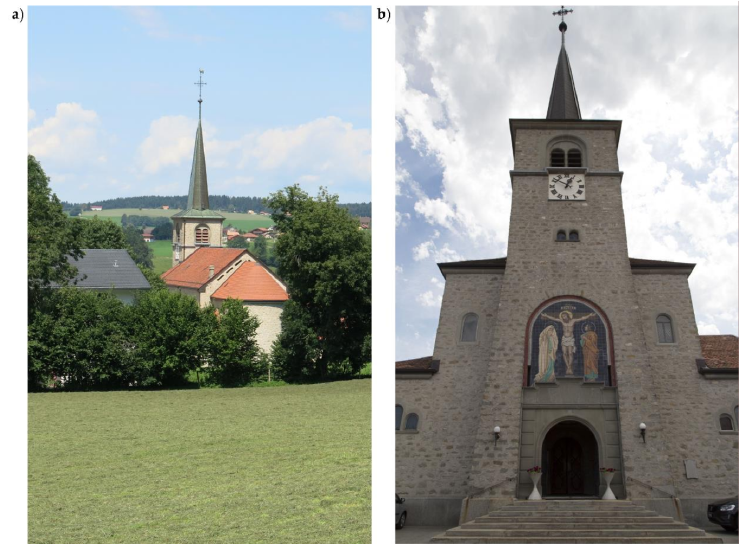
Figure 1. Exterior views of the Church of Saint Nicolas de Myre at Semsales in the Canton Fribourg. ( a ) Rural location of the church; ( b ) entrance with the Crucifixion in ceramic glazed tiles and carved stone portal by G. Severini.